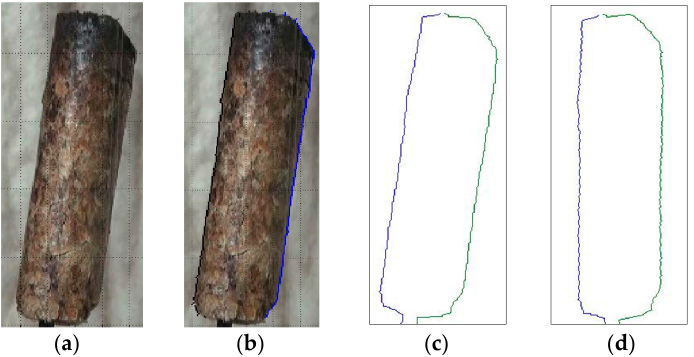
Figure 7. Wood pellet image data and image process results (finding border of wood pellet). ( a ) Raw image file; ( b ) Image file with border line; ( c ) Border line; ( d ) Border line with rotation.